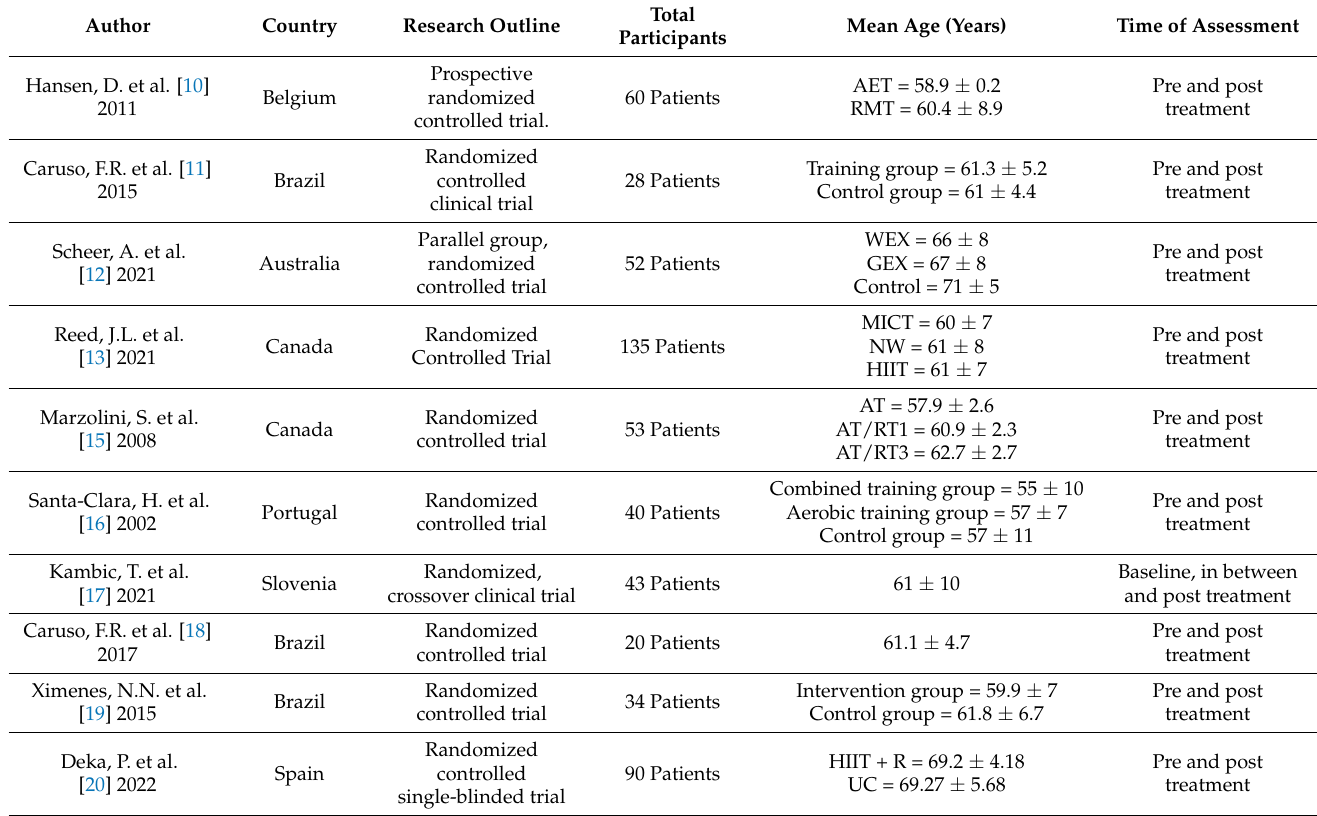
Table 1. Demographic characteristics of articles addressing the use of resistance exercises in coronary artery disease